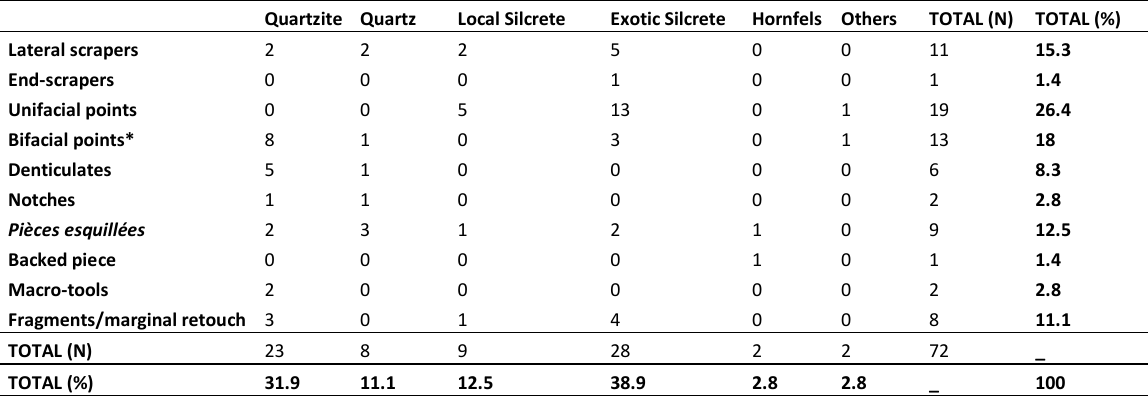
Table 3 . Typological list of retouched pieces from the stratigraphic unit Lynn (Diepkloof Rock Shelter) (*at different stages of manufacture). Quartzite Quartz Local Silcrete Exotic Silcrete Hornfels Others TOTAL (N) TOTAL (%) Lateral scrapers 2 2 2 5 0 0 11 15.3 End-scrapers 0 0 0 1 0 0 1 1.4 Unifacial points 0 0 5 13 0 1 19 26.4 Bifacial points* 8 1 0 3 0 1 13 18 Denticulates 5 1 0 0 0 0 6 8.3 Notches 1 1 0 0 0 0 2 2.8 Pièces esquillées 2 3 1 2 1 0 9 12.5 Backed piece 0 0 0 0 1 0 1 1.4 Macro-tools 2 0 0 0 0 0 2 2.8 Fragments/marginal retouch 3 0 1 4 0 0 8 11.1 TOTAL (N) 23 8 9 28 2 2 72 _ TOTAL (%) 31.9 11.1 12.5 38.9 2.8 2.8 _